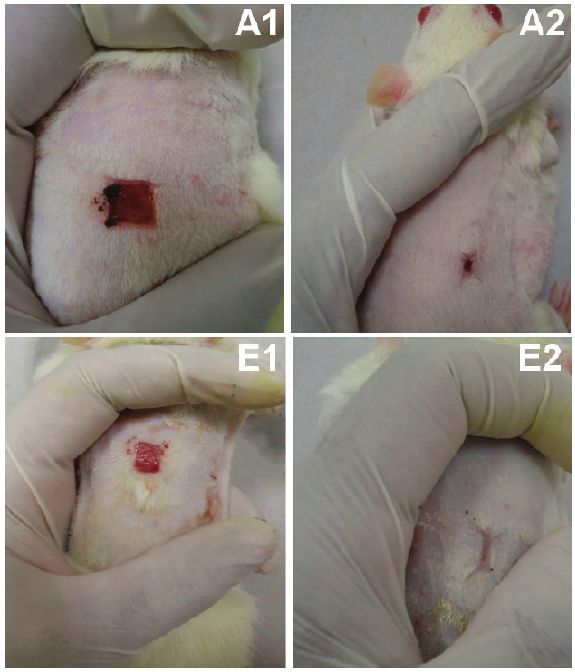
Figure 13. ( A1 , A2 ) Negative control (one week and two weeks); ( E1 , E2 ) poly(3-hydroxy butyrate- co -3-hydroxyvalerate) (PHBV) loaded with R-Spondin 1. Reprinted with permission from [127], Copyright © 2011 American Chemical Society.